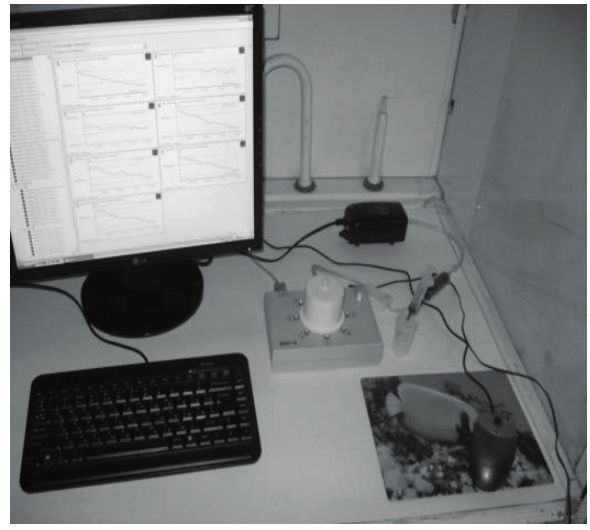
Figure 3 A general view of the workplace with the MAG-8 analyzer